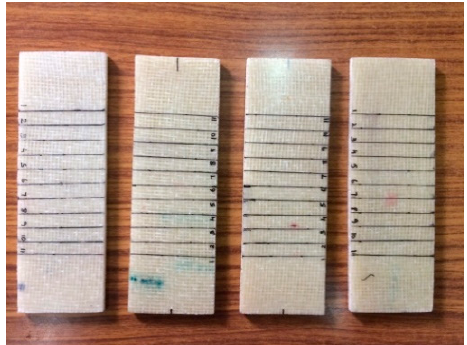
Figure 1. Samples used for the impulsive excitation of vibration.